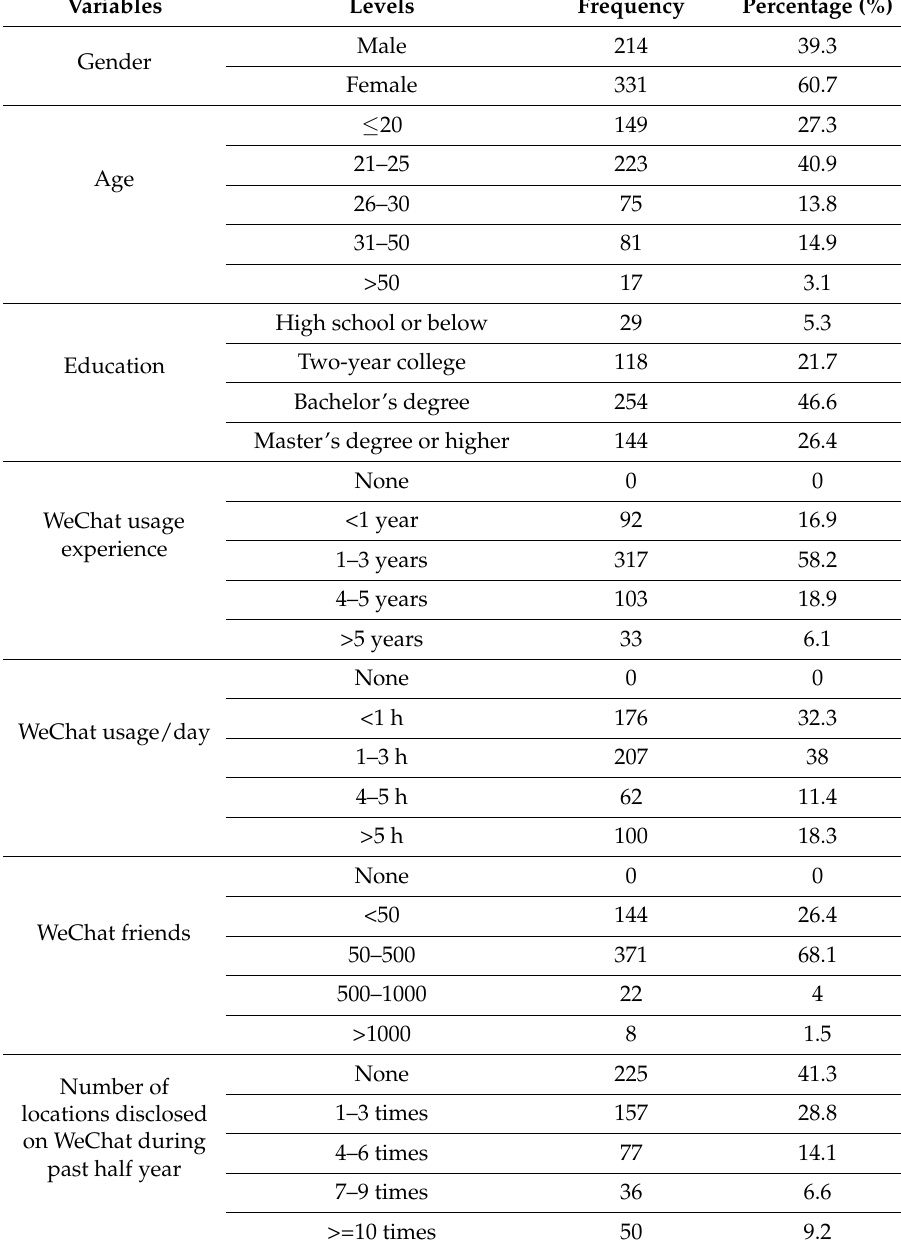
Table 1. Demographic statistics (N =